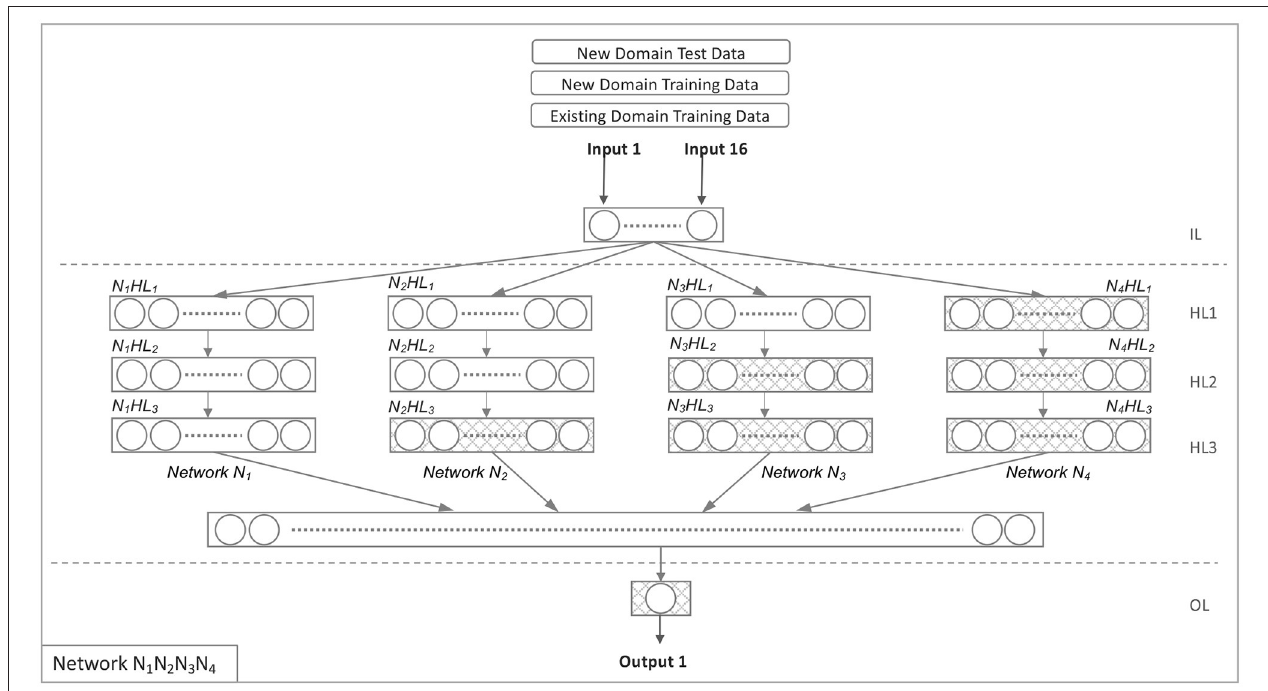
FIGURE 3 | Network N 1 N 2 N 3 N 4